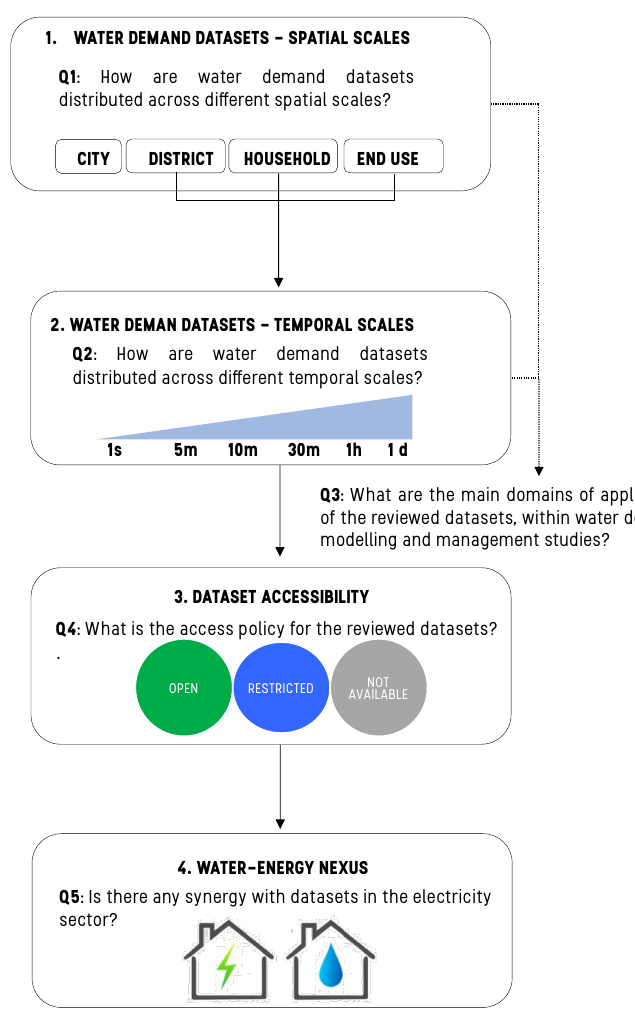
Figure 1. State-of-the-art water demand datasets review: summary of the research questions and multi-stage